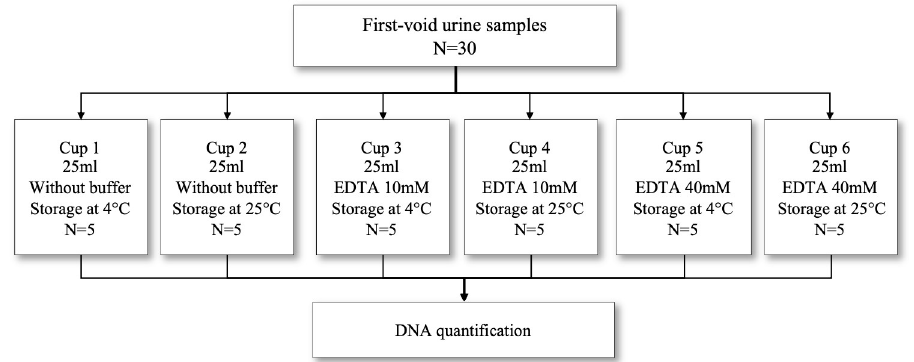
Fig 1. Overview of collection and management of urine samples to evaluate optimal EDTA concentration and storage temperature. This evaluation was performed in a set of urine samples from five volunteer women, who collected a first-morning, first-void urine sample, in six different cups (25ml each). Cups contained different EDTA concentrations added prior to urine addition: No EDTA, 10mM and 40mM EDTA. Half of the samples (the ones labeled with odd numbers) were stored at room temperature and those with even numbers were stored in the fridge at ~4˚C. DNA extraction and quantification were performed 24 hours after collection.